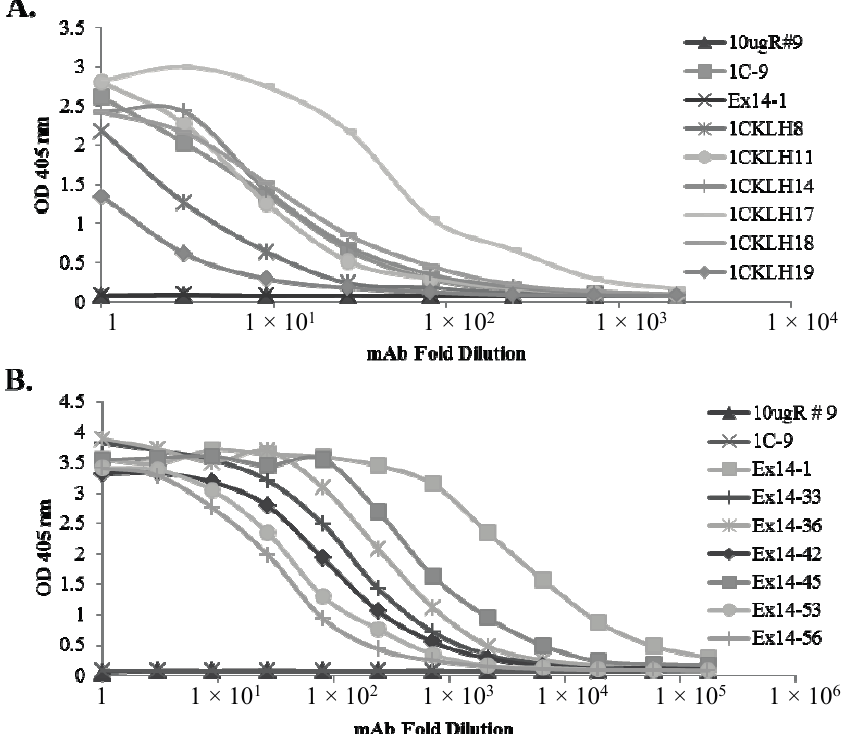
Figure 2. Hybridoma cultures were screened by ELISA against ( A ) GST-1C or ( B ) TRX-Exon14 to isolate sFlt1-1 or sFlt1-14 specific mAbs, respectively. 1CKLH18 and Ex14-1 were selected for their favorable binding properties as isoform-specific mAbs, while the total sFlt1-specific mAb, 10ugR#9, which binds a shared domain of the full-length protein, was included as a negative